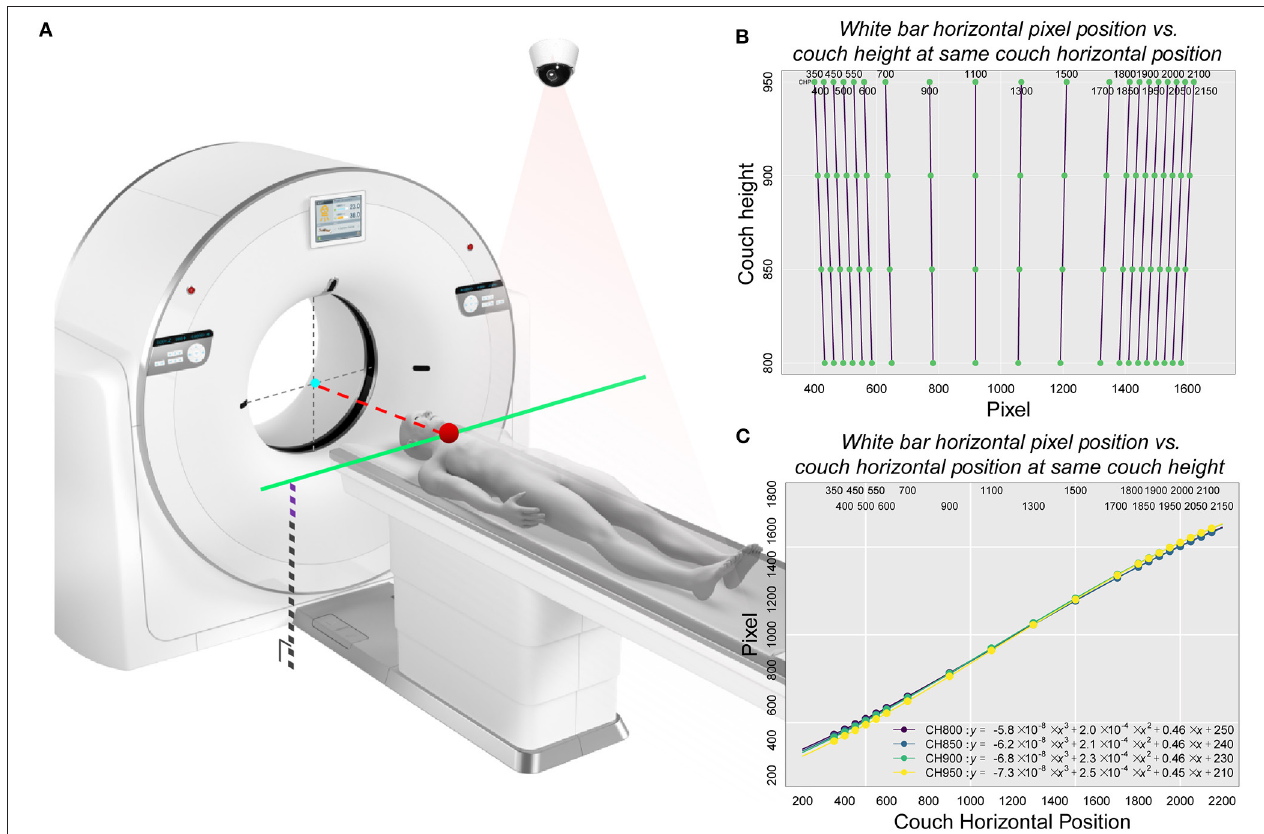
FIGURE 3 | Schematic representation of the principle of calibration used in the study and the corresponding relationship between pixel position and couch height as well as between pixel position and the couch code with the white bar as the correction object. (A) The basic principle of automatic positioning of the CAPITAL-CT scanning couch. This diagram included key factors associated with both the CT scanner and the 2-dimensional camera. An important point related to the camera was the pixel position point imaged inside the camera where the key starting position point in the camera detection process was located. This point, which was also a critical part of the scanner, corresponded to the jaw position (the red dot on the solid green line) where the subject was located on the CT scan couch. Since the protocol was already selected, the CT scan couch automatically obtained a fixed couch height and altitude compensation (black dotted lines superimposed with purple dashed lines). Since the position of the isocenter (gray dotted cross with a cyan point) was given, the pixel points of the starting position and the height of the scanning couch were known, the displacement distance of the scanning couch (red dotted line) could be obtained by looking up the calibration table. (B) Linear relationship between the horizontal pixel position of the white bar and the couch height under the same couch code. (C) Non-linear relationship between the horizontal pixel position of the white bar and the couch code at the same couch